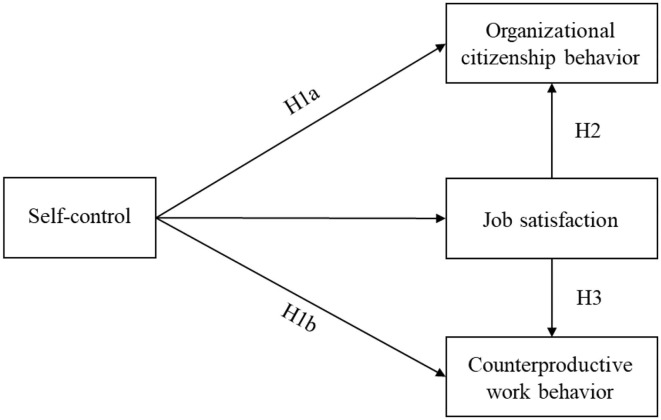
Theoretical model.